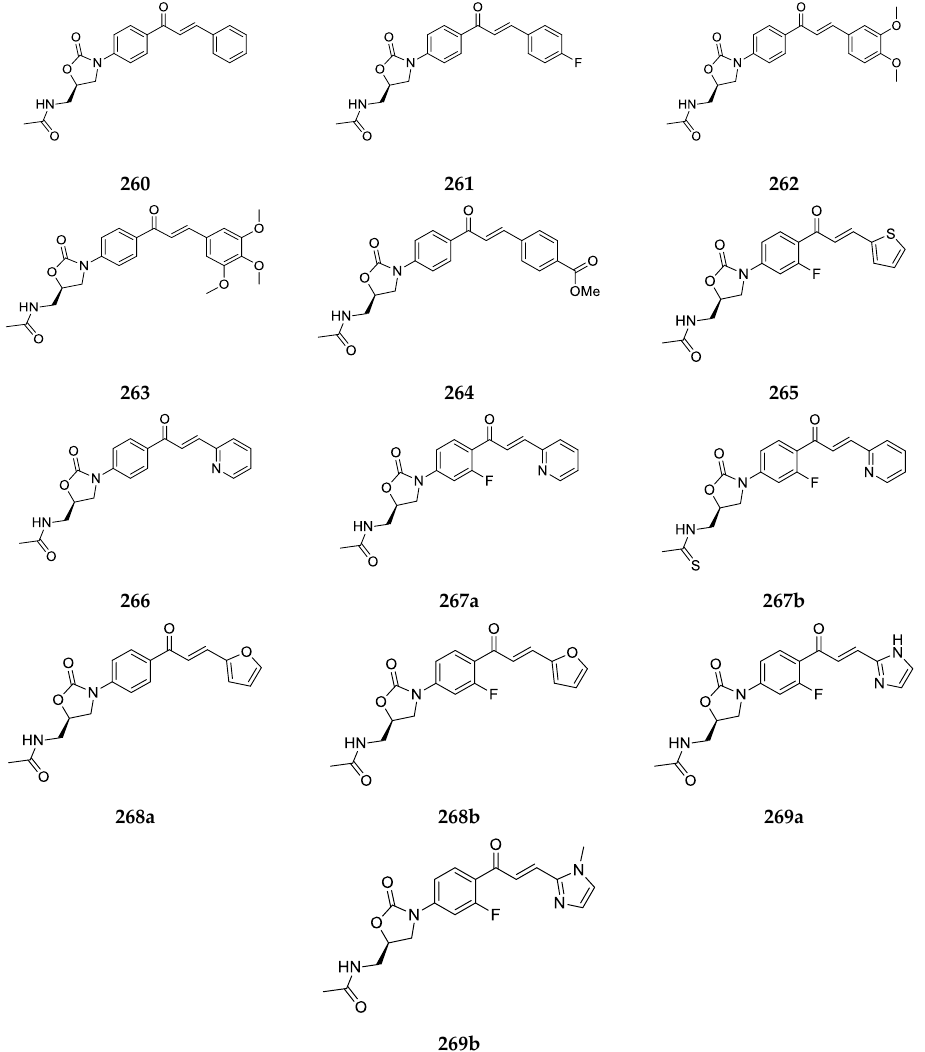
Figure 73. Chemical structure of 2-oxo-oxazolidin-3-yl-chalcone derivatives with substitution on ring